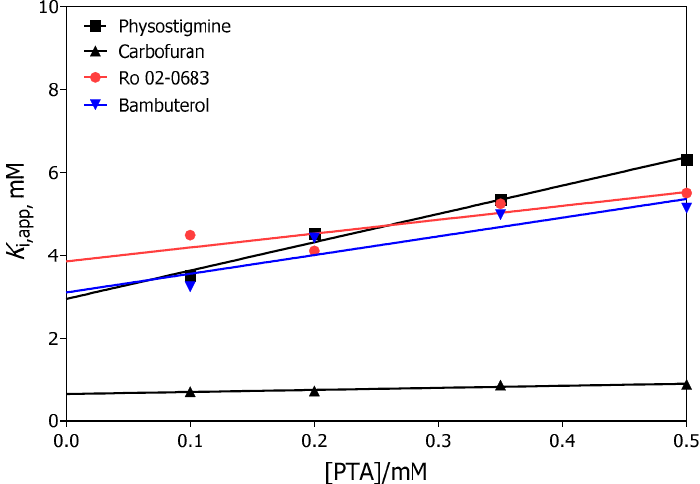
Figure 3. Inhibition of rePON1 hydrolysis of PTA by selected carbamates evaluated by linear regression from at least three experiments.